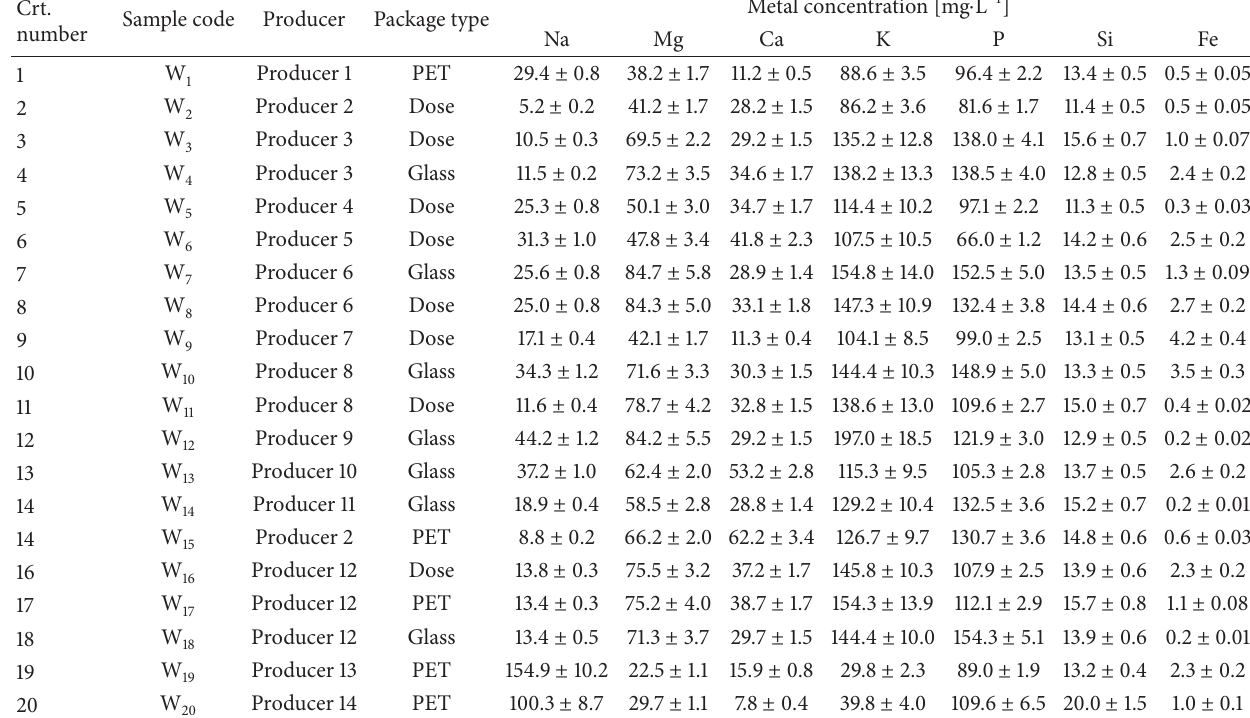
Table 1: The concentration of major metals in studied beers (mean and RSD %).